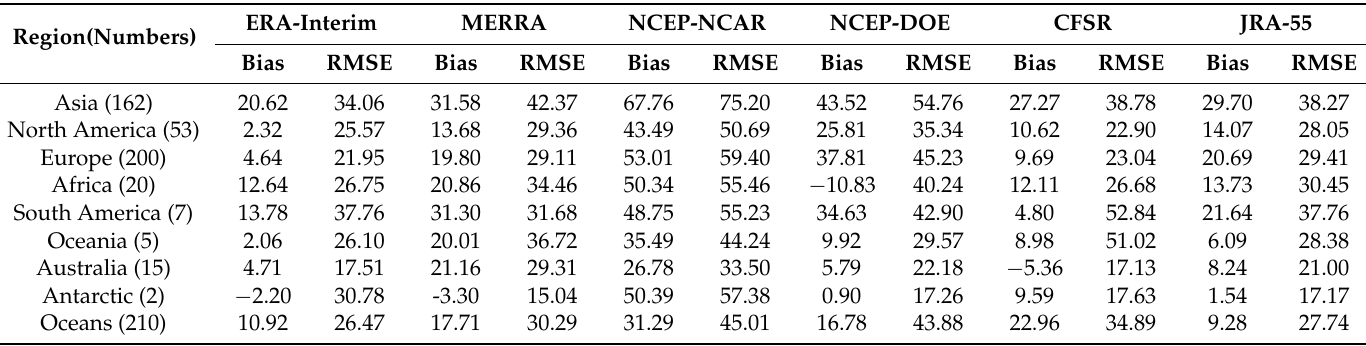
Table 4. Evaluation of the monthly R s from six reanalysis data sets using surface measurements in various sub-regions from 2001 to 2009. The numbers of observational stations are shown in brackets in the first column. Units are W/m 2 for Bias and